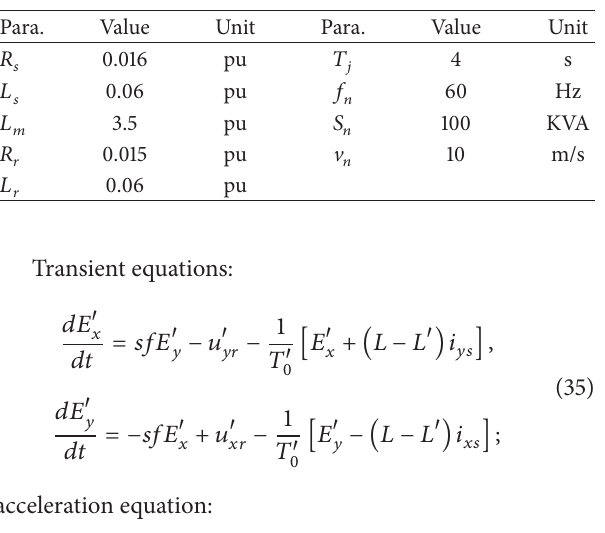
Table 2: Induction motor